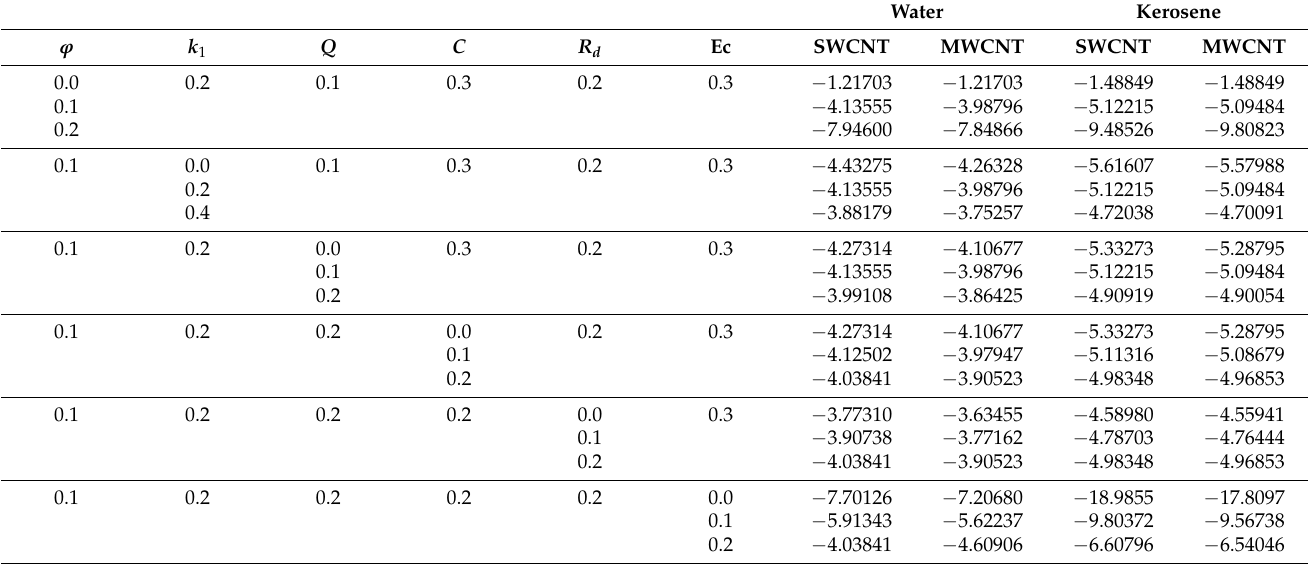
Table 3. Numerical values of various parameters for Nusselt